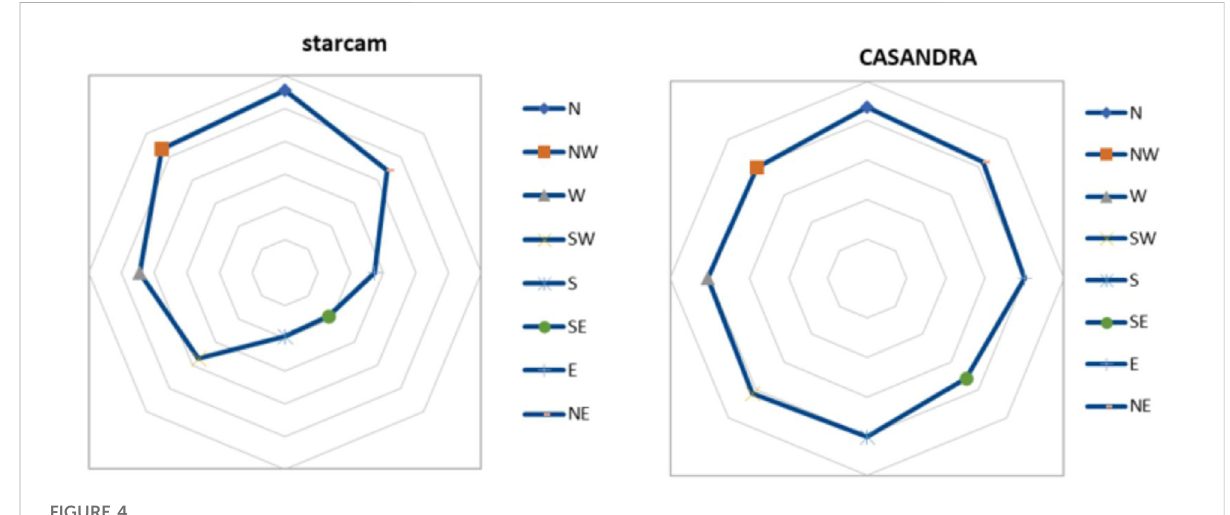
FIGURE 4 Percentage of hits according to wind direction frequencies.